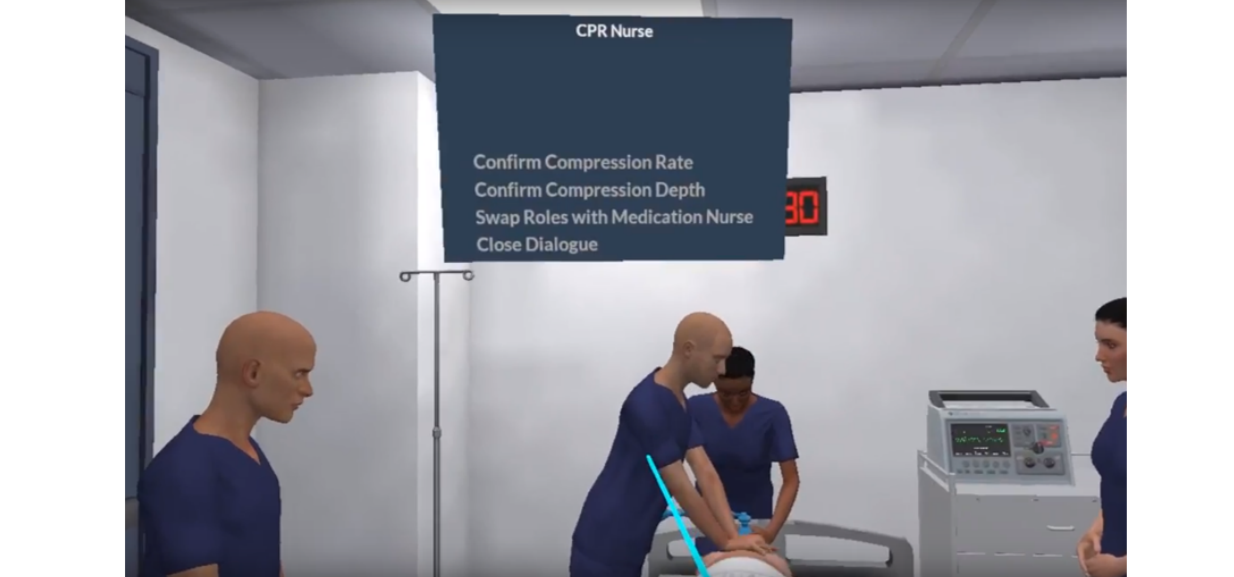
Figure 2. Interactions with virtual team